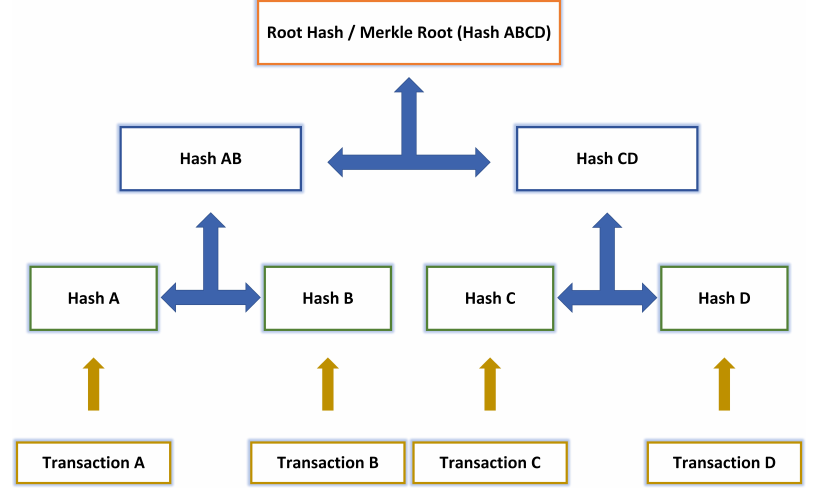
Figure 4. Blockchain Merkle tree